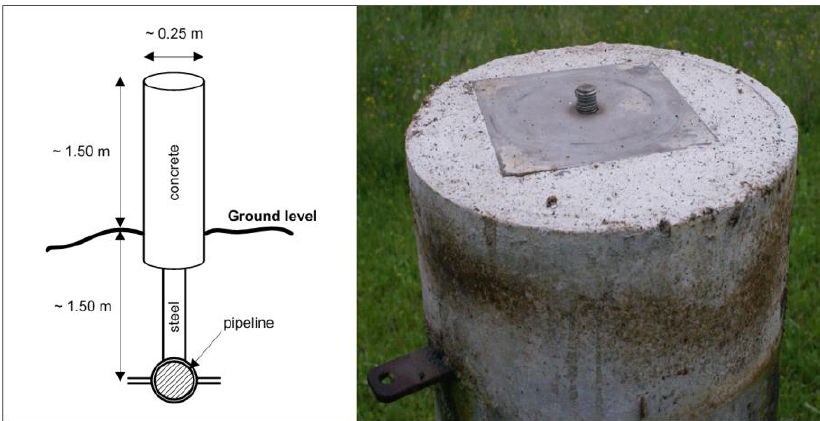
Figure 2. Pillars used for monitoring the movements of the underground